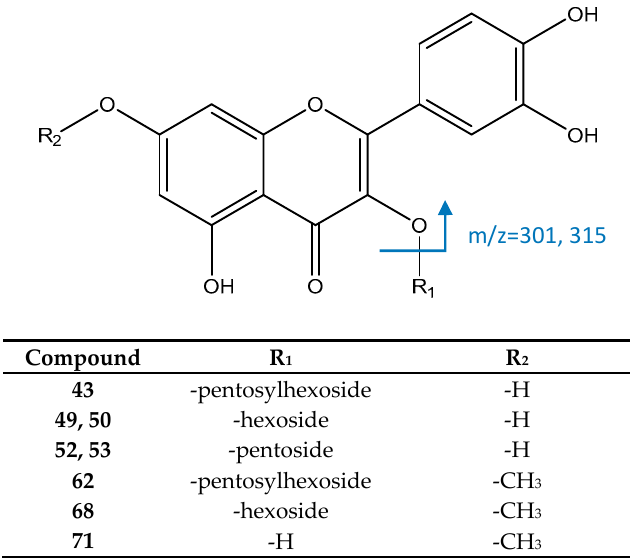
Figure 11. Structure and fragments of flavonoids.